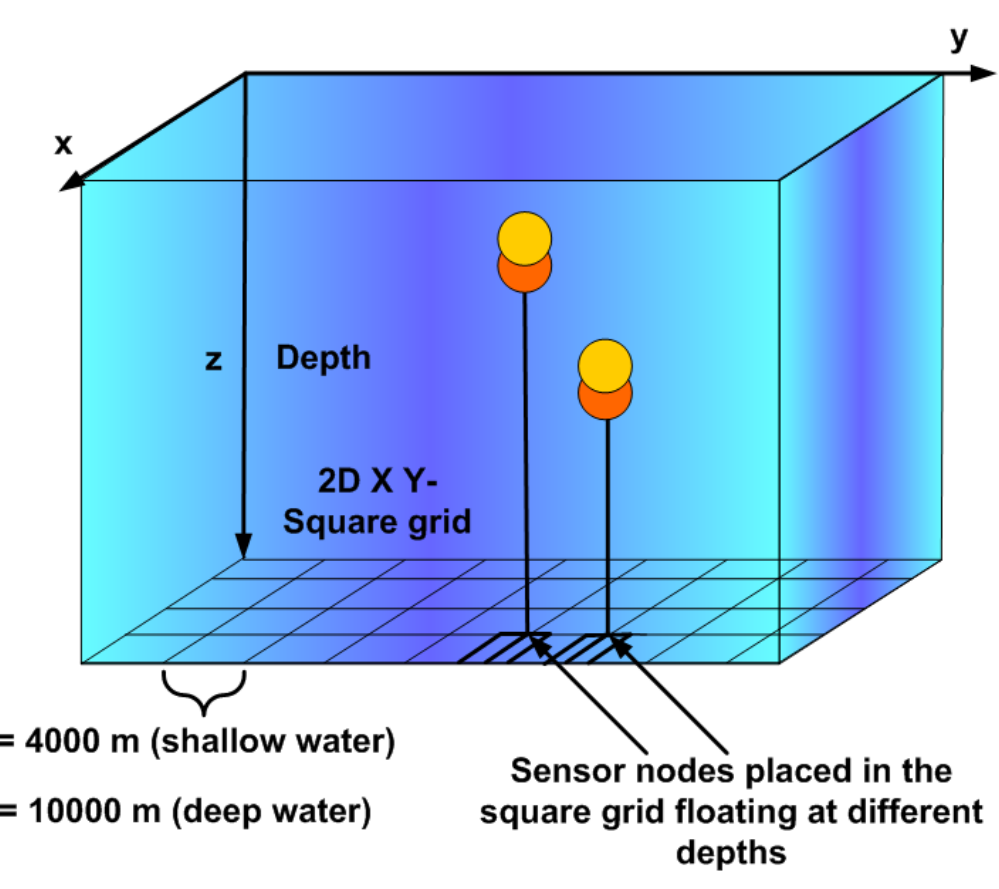
Figure 6. 2D Square